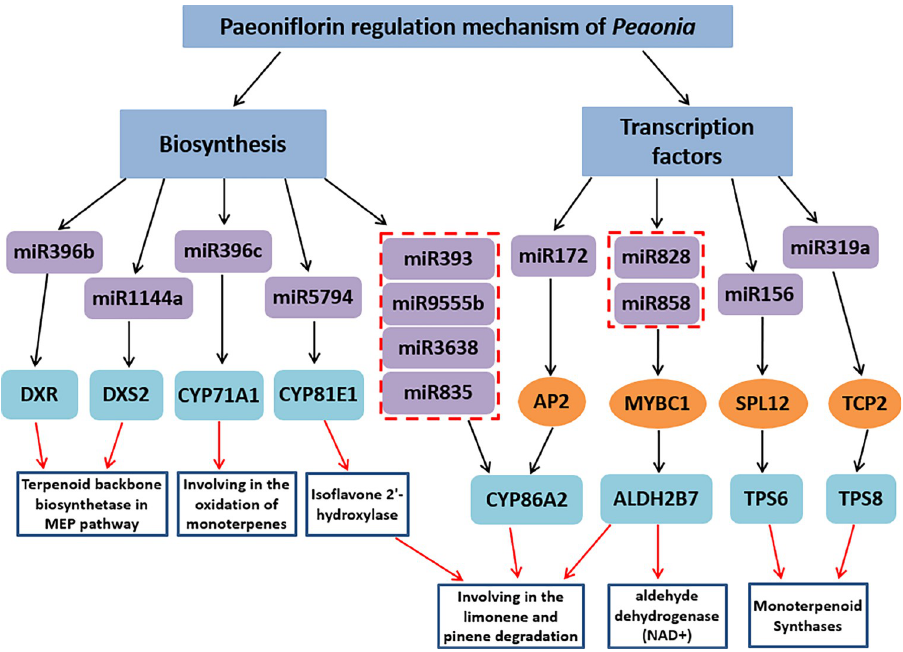
Fig 13. Paeoniflorin regulation mechanism of Paeonia